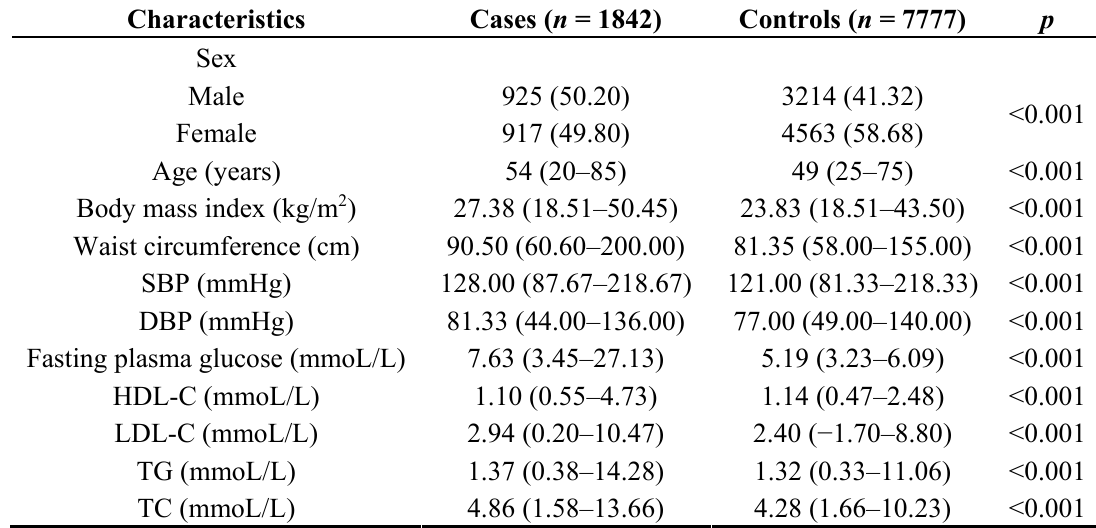
Table 1. Characteristics of study participants.